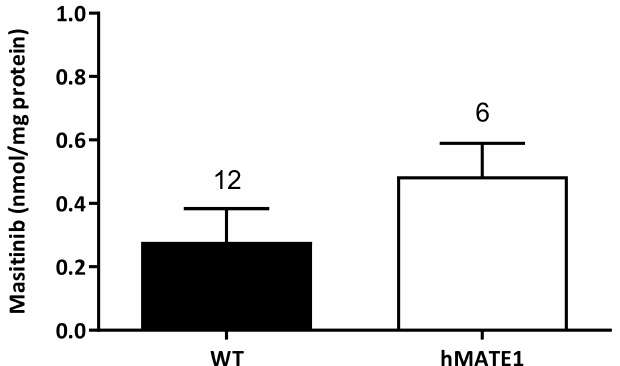
Figure 4. Columns indicate Masitinib temperature-dependent accumulation (accumulation measured at 37 ◦ C minus accumulation measured at 4 ◦ C) in WT- ( n = 12) and hMATE1- ( n = 6) HEK293 cells. Columns show the mean ± SEM of Masitinib uptake given as nmol Masitinib/mg protein measured in 12 and 6 replicates for WT- and hMATE1-HEK293 cells, respectively, in 3 independent experiments.